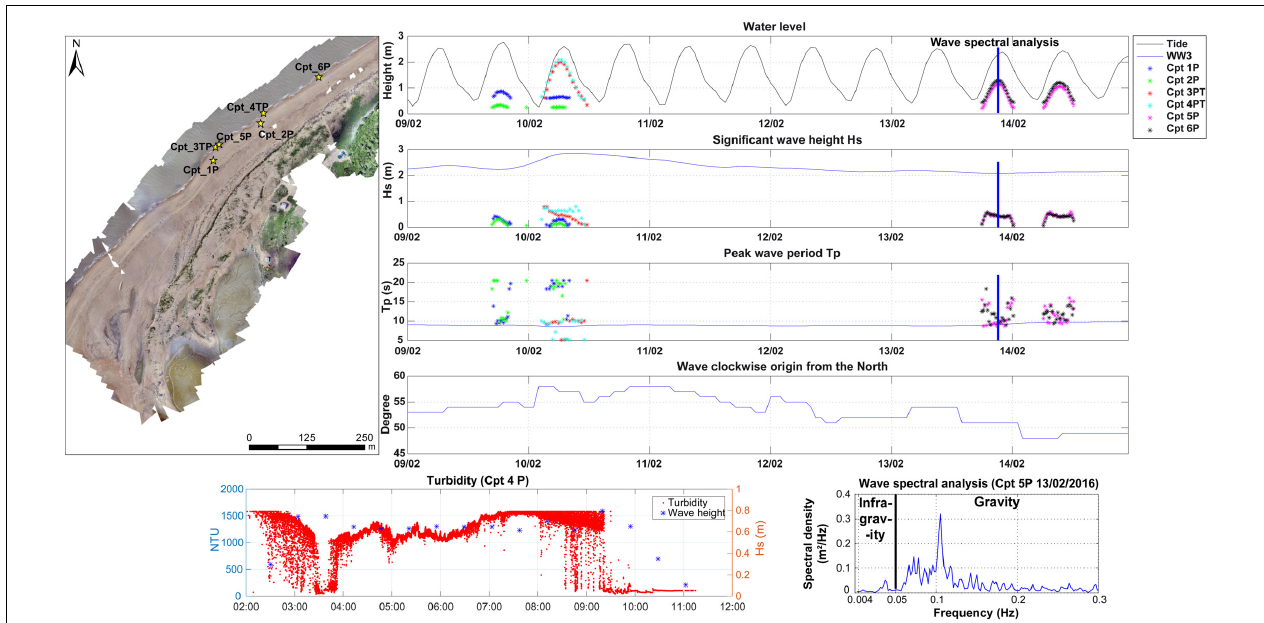
FIGURE 8 | Hydrodynamic conditions affecting Braamspunt beach from 9 to 14 February, 2016. From top to bottom: tidal variations depicted as water level, significant wave height (Hs), peak wave period (T), deep-water wave directions derived from the WAVEWATCH III model; (Hs) and turbidity values (NTU), showing, in the case of sensor Cpt 4 PT, a clear relationship between wave height and sediment put into suspension in the course of wave breaking. Drone-derived orthophotograph on the left shows the locations of the wave and turbidity sensors deployed in the course of the two